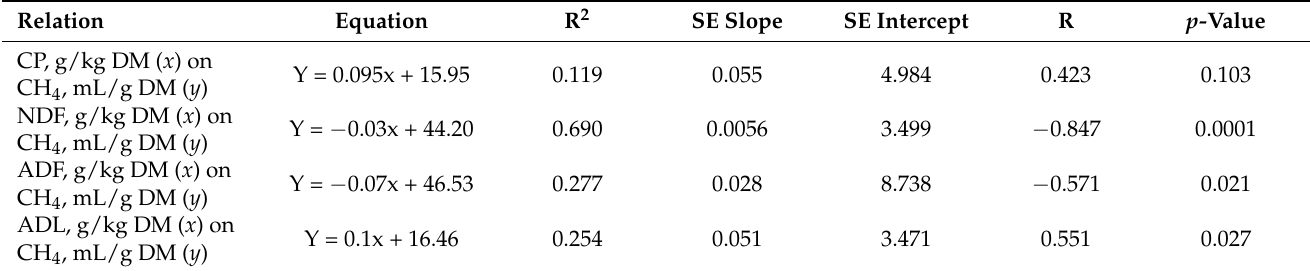
Table 3. Correlation between nutritional content and methane